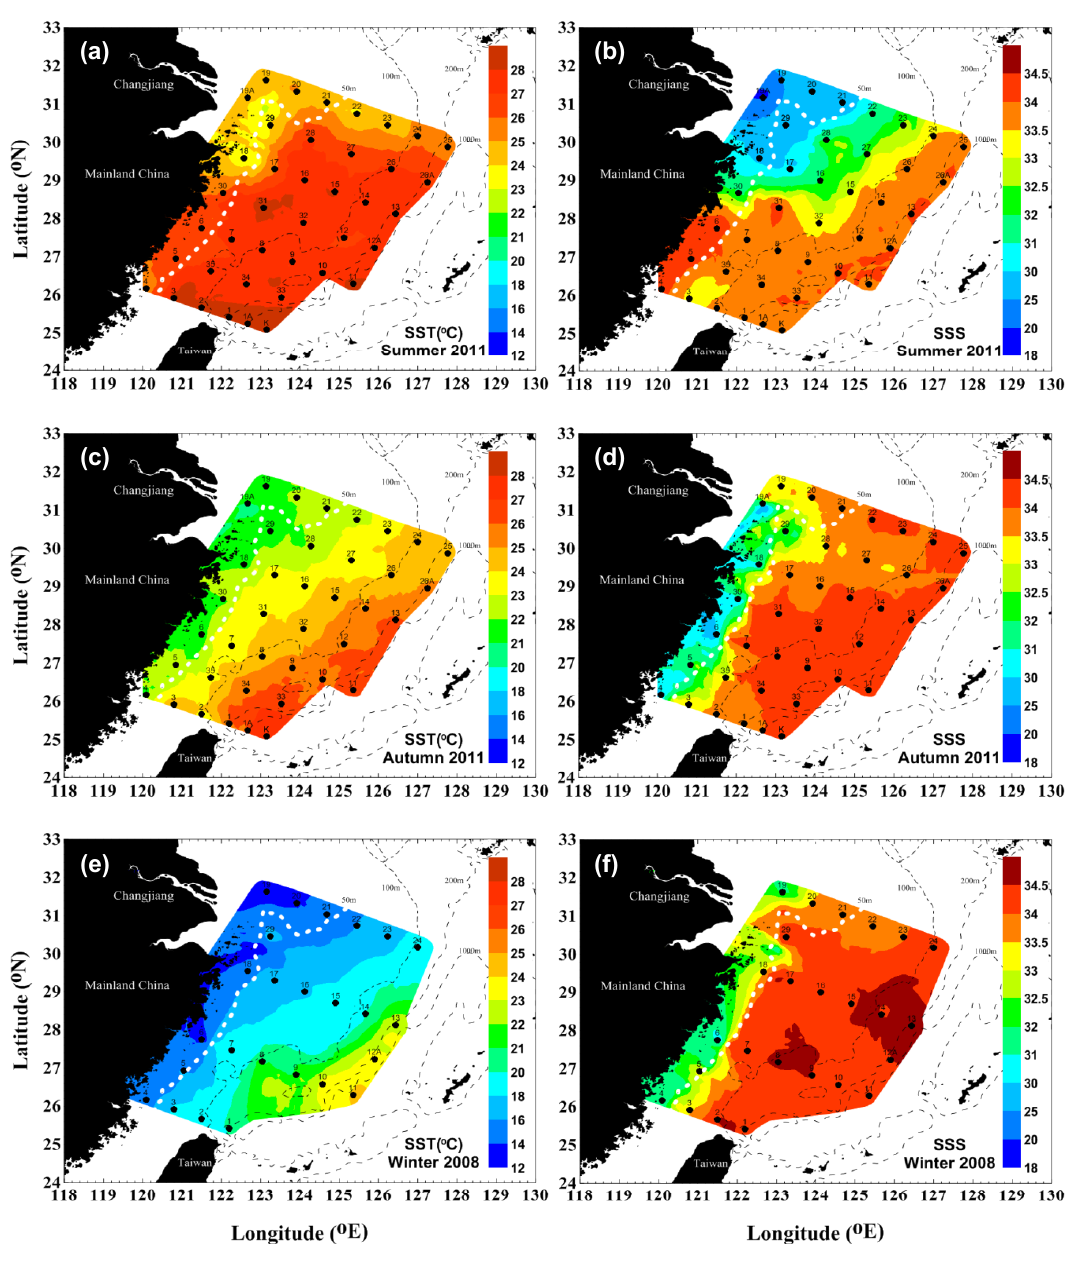
Fig. 1. Spatial distributions of (a) SST in summer 2011, (b) SSS in summer 2011, (c) SST in autumn 2011, (d) SSS in autumn 2011, (e) SST in winter 2008 and (f) SSS in winter 2008 on the East China Sea shelf. SST: sea surface temperature. SSS: sea surface salinity. The bold dotted line indicates the 50m